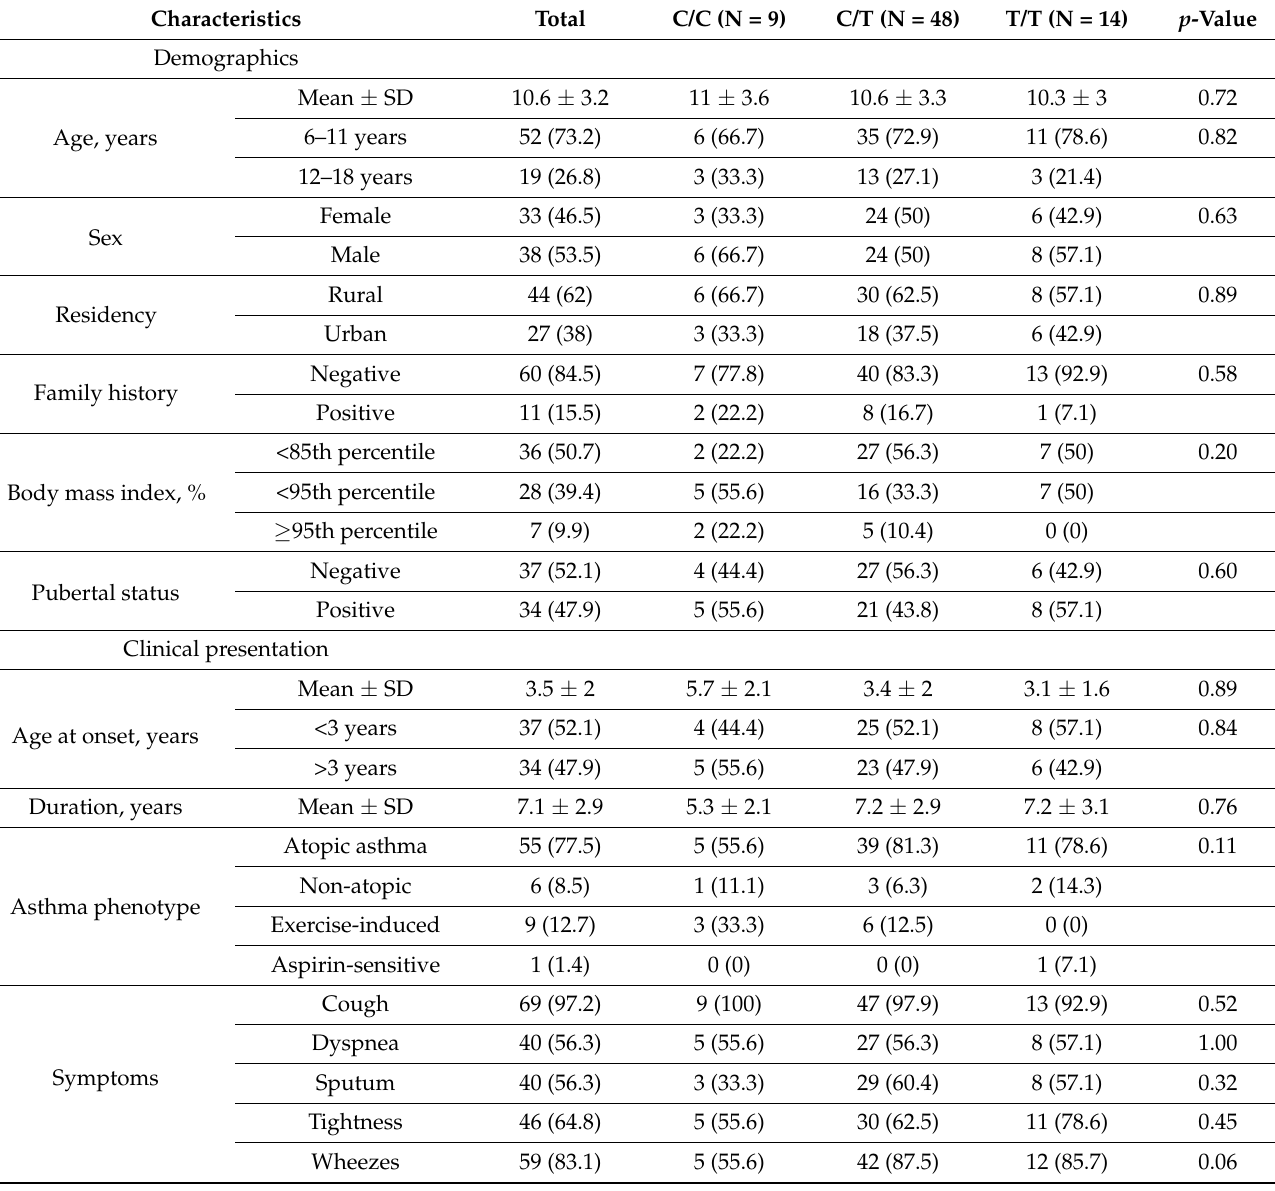
Table 4. Association of HSPA1A genotypes with demographic and clinicolaboratory data in patients with BA (N = 71